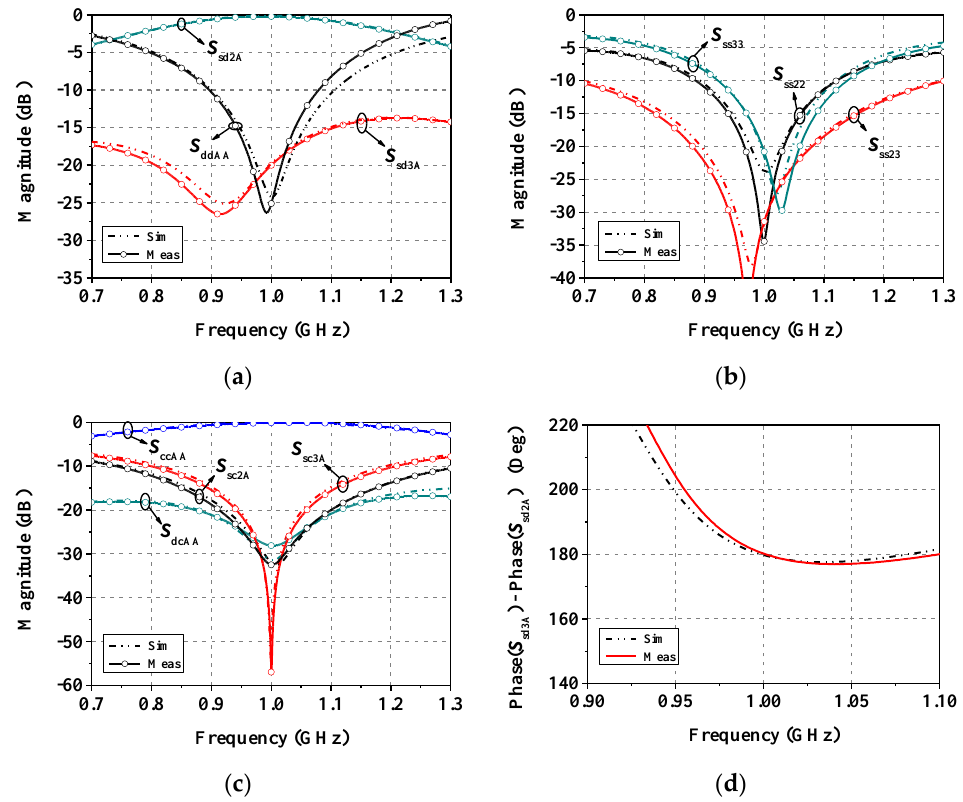
Figure 8. Performances of the proposed 20-dB BTU power divider. ( a ) | S sd2A |, | S sd3A |, and | S ddAA |. ( b ) Output ports isolation and return loss. ( c ) | S ccAA |, | S sc2A |, | S sc3A |, and | S dcAA |. ( d ) Phase difference between the output ports.